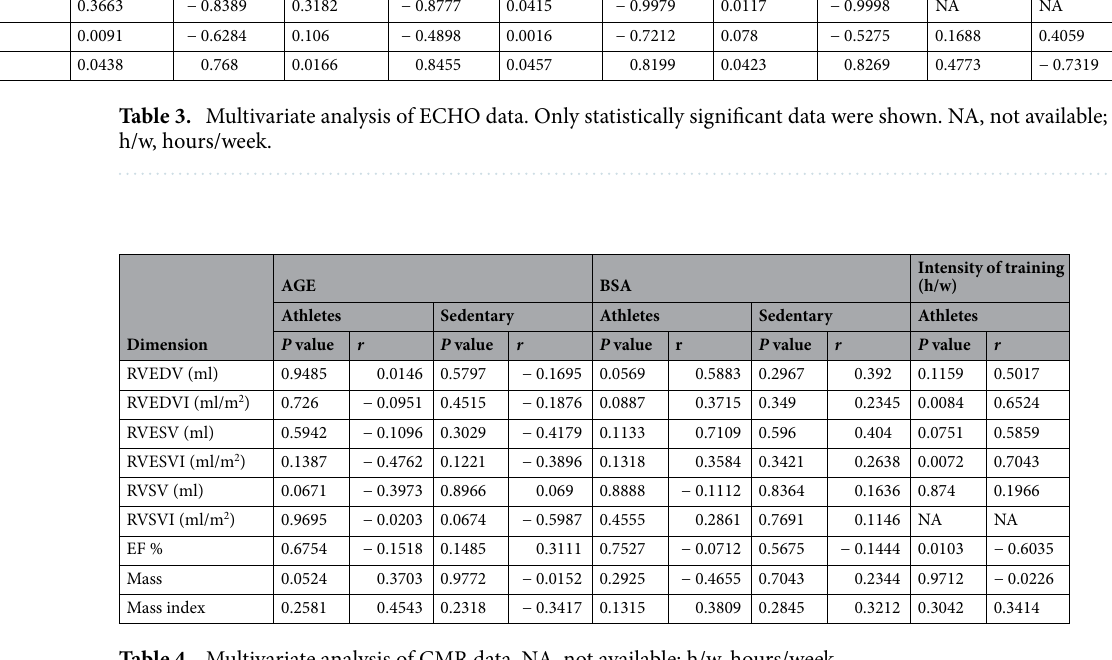
Table 4. Multivariate analysis of CMR data. NA, not available; h/w, hours/week.